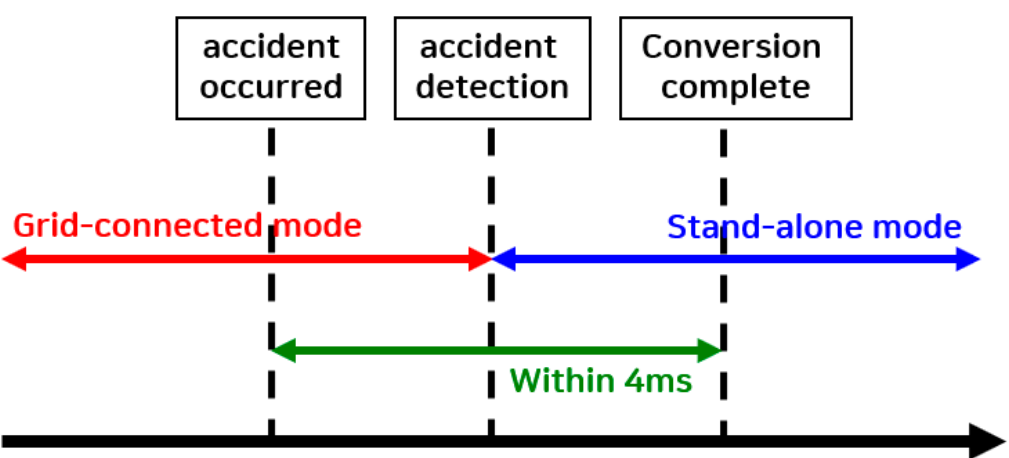
Figure 7. Mode-switching sequence in a microgrid inverter.